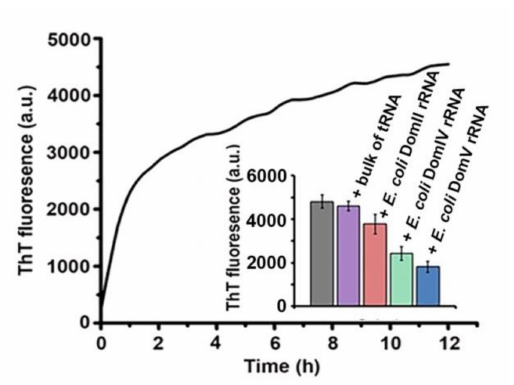
Figure 2. The e ff ect of di ff erent RNAs on HET-s aggregation monitored by ThT binding. HET-s aggregation was induced as mentioned in the Materials and Methods section and tested for ThT binding. The curve shows resulting ThT fluorescence (Emission 483 nm, excitation at 450 nm) with time. The inset represents the saturating values of ThT fluorescence (at 483 nM) without (gray bar) or with various RNAs as indicated. The data presented here are average of three independent measurements and the error bars represent standard